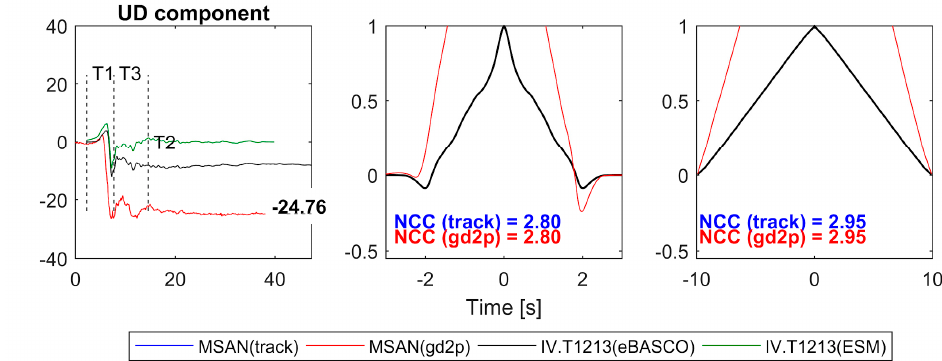
Figure A1. Comparison between displacement time series (two horizontal and vertical component) obtained by the eBASCO method (black line) and from the ESM database (green line) recorded at the IV.T1213 station during the Mw6.5 Norcia earthquake and HRGPS time series from the co-located MSAN station. The coseismic displacement measured by HRGPS is also reported in the 1st column of each plot together with the correction points (T 1 , T 2 and T 3 ). Normalized autocorrelation function (ACC) (black line) and normalized cross-correlation (NCC) function between HRGPS and eBASCO displacement (red line) are shown in the 2nd and 3th columns. ACC and NCC were calculated between T 1 and T 2 (2nd column) and between T 3 and the end of signal (3th column); dist: interdistance between strong-motion and GPS station; srt: sampling rate of the HRGPS records; gd2p and track: different processing schemes of the HRGPS data (http://gipsy.jpl.nasa.gov (accessed on 29 December 2020), [27]; http://wwwgpsg.mit.edu/~simon/gtgk/ (accessed on 29 December 2020), [28]). Geosciences 2020 , 10 , x FOR PEER REVIEW